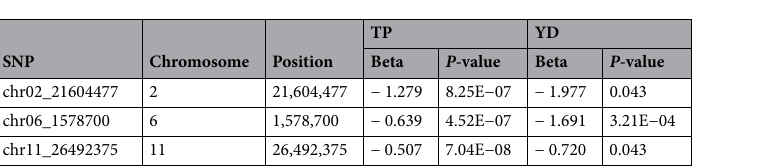
Table 3. Information about instrumental variables.